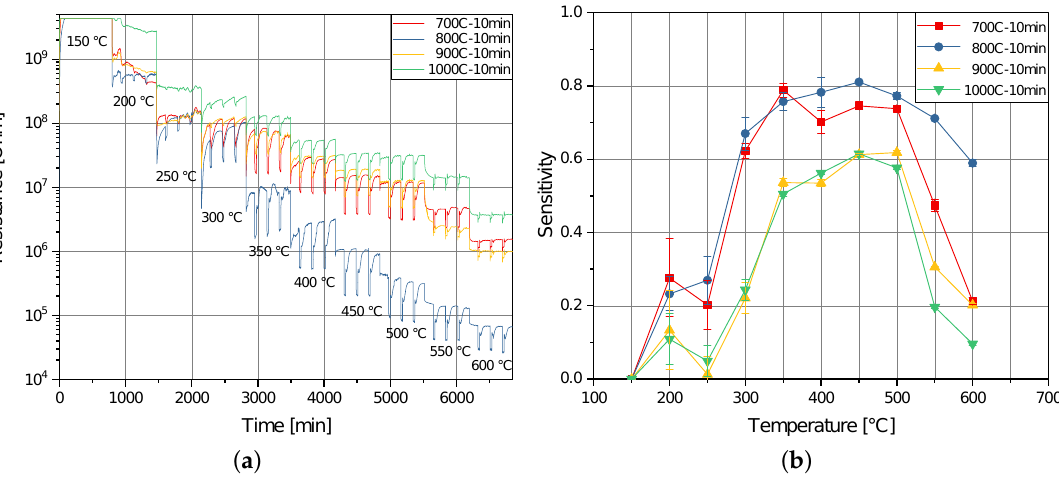
Figure 7. Restive changes of the sensors during the measurement program ( a ) and temperature dependency of the sensor sensitivity depending on the sintering temperature, all with a fixed sintering time of 10 min ( b ). The sensor name is the combination of the sintering temperature ( ◦ C ) and respective holding time. The temperature information in ( a ) shows the working temperature of the sensors. All experiments were performed in synthetic air. Acetone was used as the test gas and diluted to 5 ppm with synthetic air while maintaining a total flow of 200